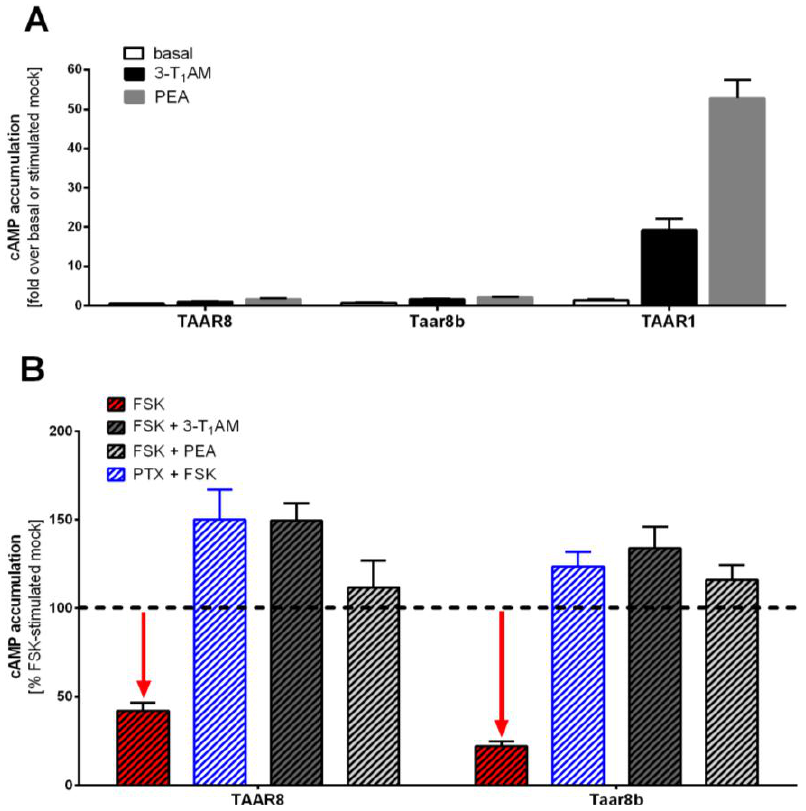
Figure 4. cAMP accumulation after G s and G i/o coupling, respectively. HEK293 cells were stimulated with either 3-T 1 AM (black) or PEA (grey) for determination of potential G s signaling ( A ) or co-stimulated with forskolin (FSK) and 3-T 1 AM (dark grey, hatched), PEA (light grey, hatched) or pertussis toxin (PTX) (blue hatched), for determination of potential G i/o signaling ( B ). Accumulation of cAMP was determined by AlphaScreen technology as described in the methods section. Data are represented as mean ± SEM of cAMP accumulation in fold over basal or stimulated mock-treated cells, based on two to seven independent experiments, each performed in triplicate. ( A ) Mock-transfected cells showed basal cAMP levels of 0.71 ± 0.13 nM. The human TAAR1 served as a positive control; ( B ) Mock-transfected cells demonstrated basal cAMP levels of 18.5 ± 1.1 nM. Murine and human TAAR8 showed basal G i/o coupling activity, indicated by a low basal cAMP accumulation compared to mock transfected cells (dotted line = mock 100% baseline) and by increased cAMP accumulation following pre-incubation with PTX and stimulation with